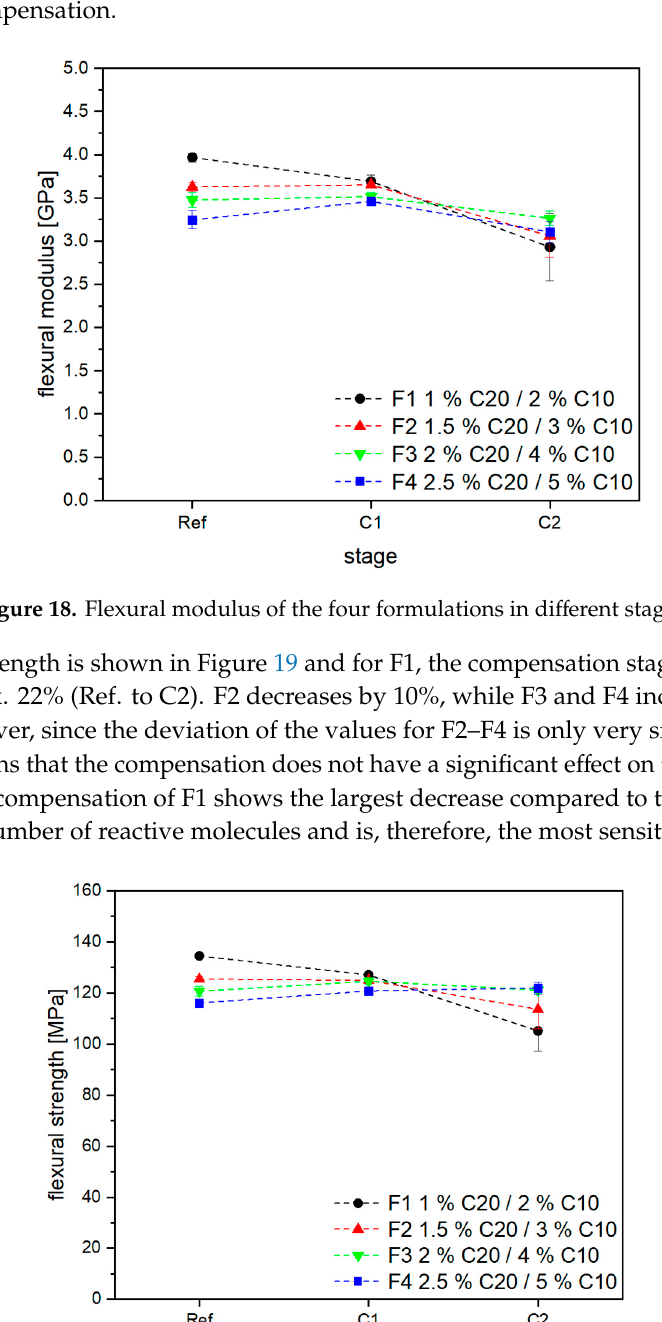
Figure 19. Flexural strength of the four formulations in different stages.